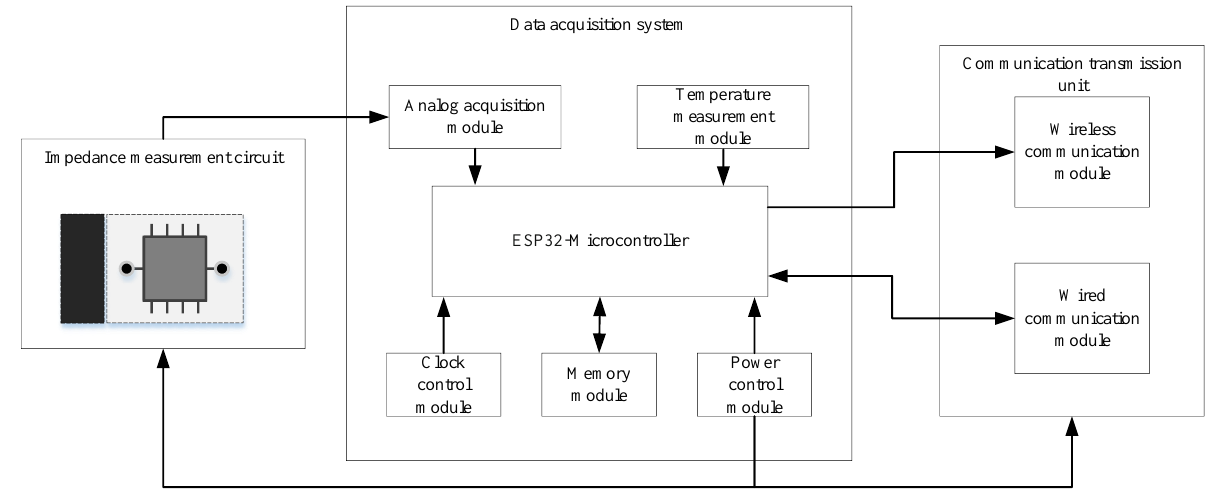
Figure 5. A schematic diagram of the overall hardware circuit system.